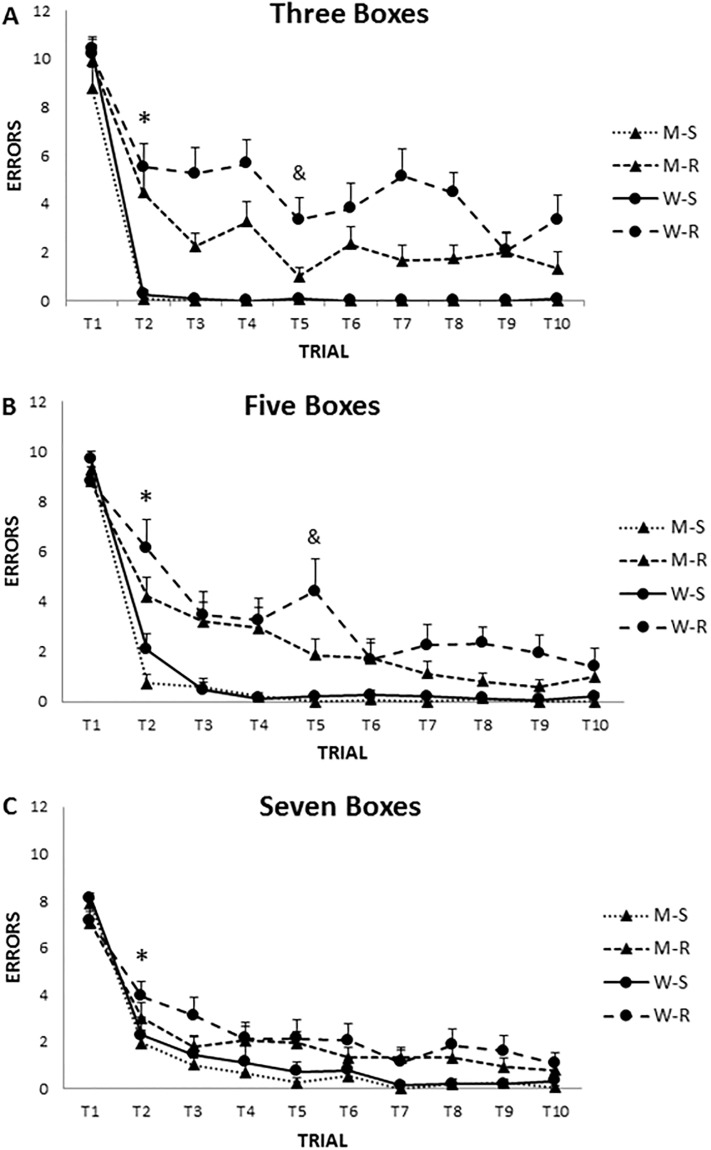
Errors made in the NWSBRT.A) Three boxes condition. B) Five boxes condition. C) Seven boxes condition. Note that in the stable condition, errors increased with task difficulty. Conversely, errors decreased with the increase of the level of difficulty in the rotated condition. & gender differences; * decrease of number of errors (p<0,05). M-S (men stable), M-R (men rotated), W-S (women stable), W-R (women rotated). Mean± SEM.